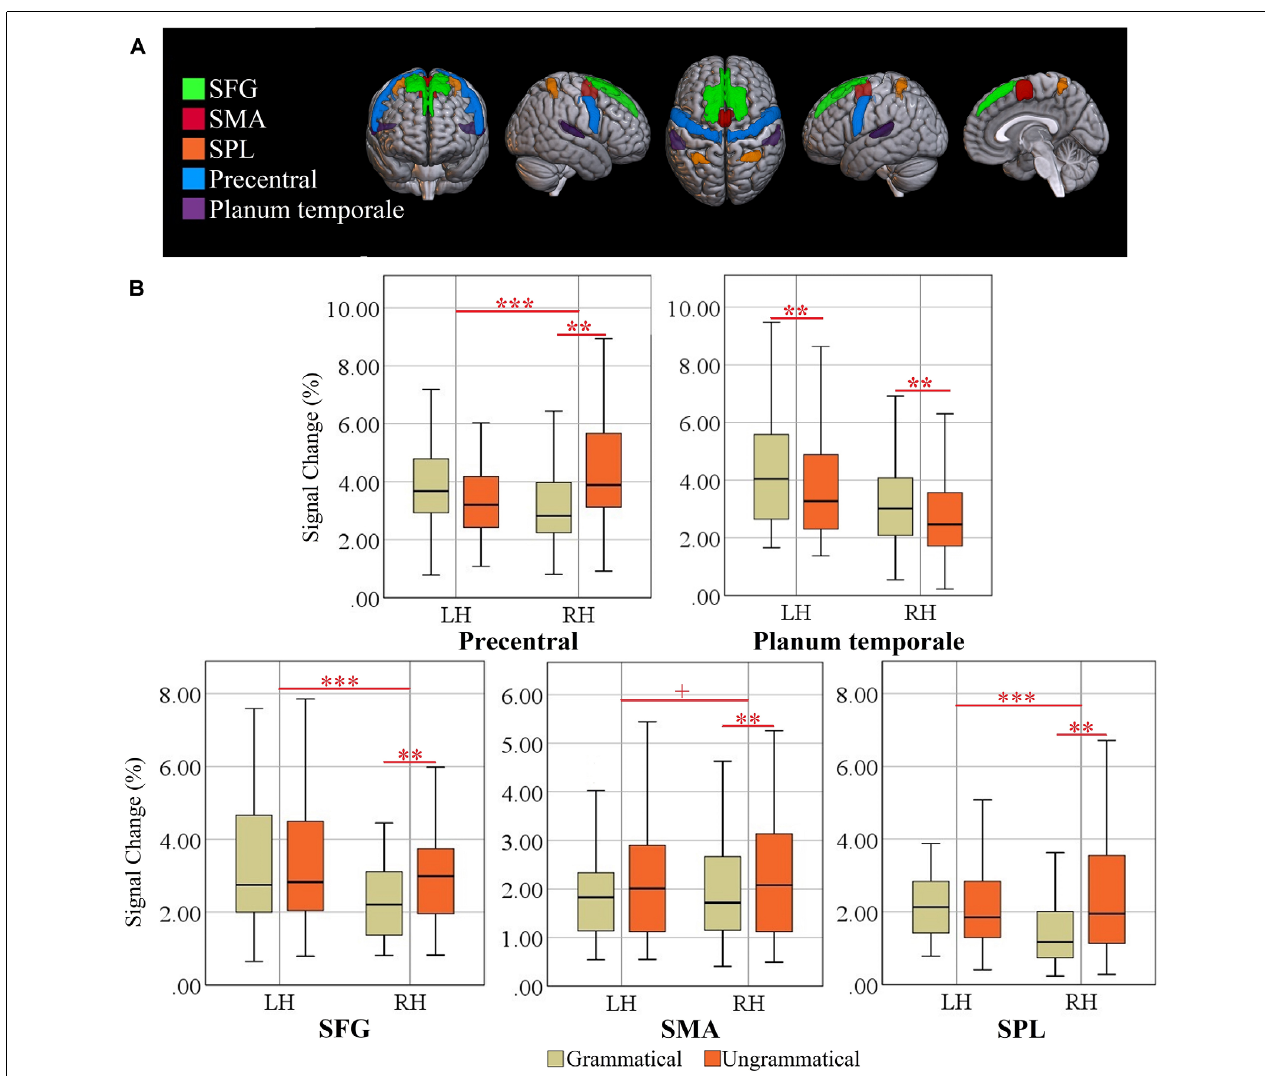
FIGURE 4 | (A) Locations of ROIs. Superior frontal gyrus (SFG), supplementary motor area (SMA), superior parietal lobule (SPL), precentral gyrus, and planum temporale (PT). (B) Box plots of percent signal change (%SC) for left and right hemisphere (LH vs. RH) and grammatical and ungrammatical conditions. Significant effects are indicated by the horizontal red bar (repeated measures ANOVA, ∗∗∗ p < 0.0041; Post-hoc ANOVA, ∗∗ p < 0.0020, Bonferroni-corrected). The plus sign denotes trends at p < 0.0041 (Bonferroni-corrected).